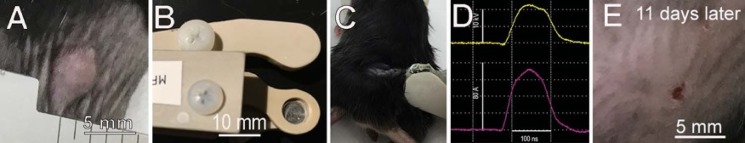
NPS application.(A) Photo of a typical shaved C3.43 tumor prior to treatment. (B) Pinch electrode used to treat these tumors. (C) Pinch electrode sandwiching a tumor as NPS is applied. (D) Oscilloscope trace of voltage (top) and current (bottom) applied to the tumor in each pulse. (E) Photo of the treated tumor in “A” 11 days later.